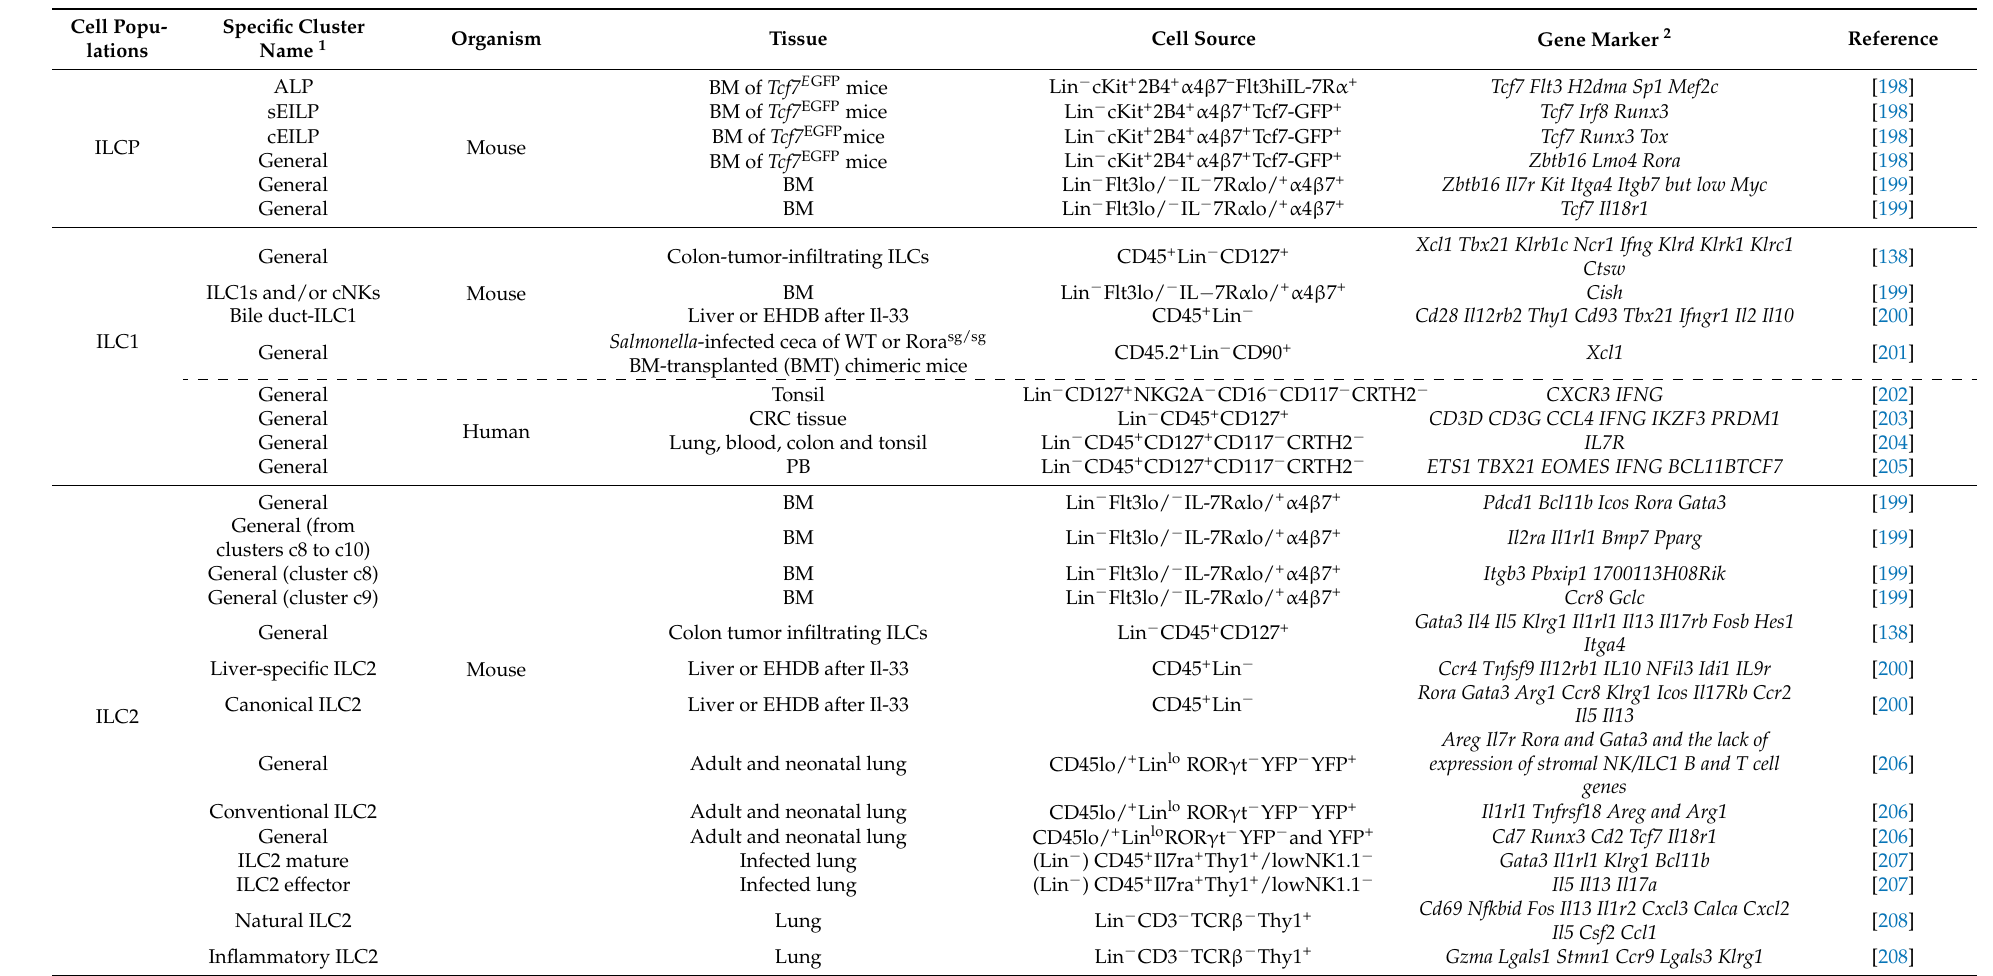
Table 2. ILC/NK classification using scRNA-seq analyses: gene markers of both humans and mice are reported. Dashed lines and upper/lower-case characters separate the genes markers of the two